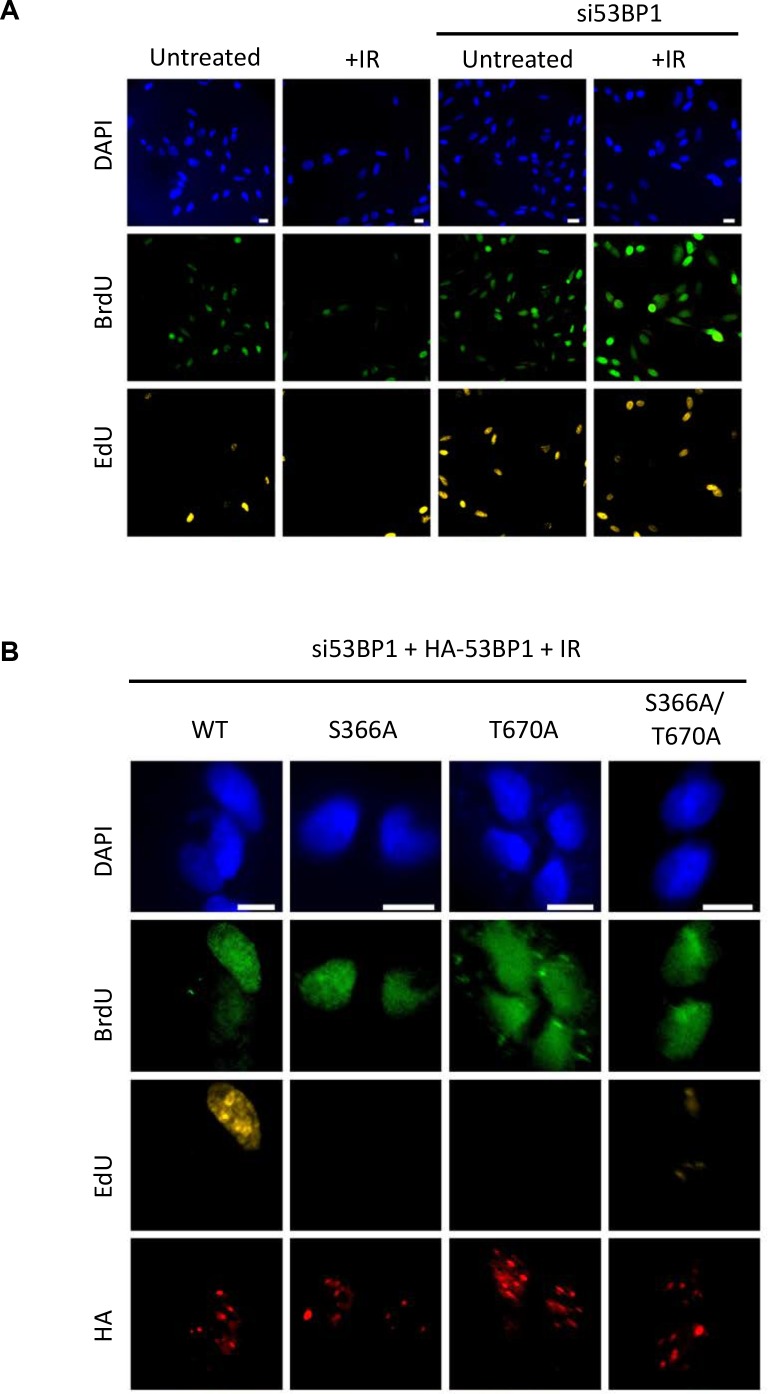
TOPBP1-53BP1 co-localization and G1/S Checkpoint defects in U2OS cells.(A) Data underlying Figure 4C, but shown as separate channels. (B) Data underlying Figure 4D, but shown as separate channels.